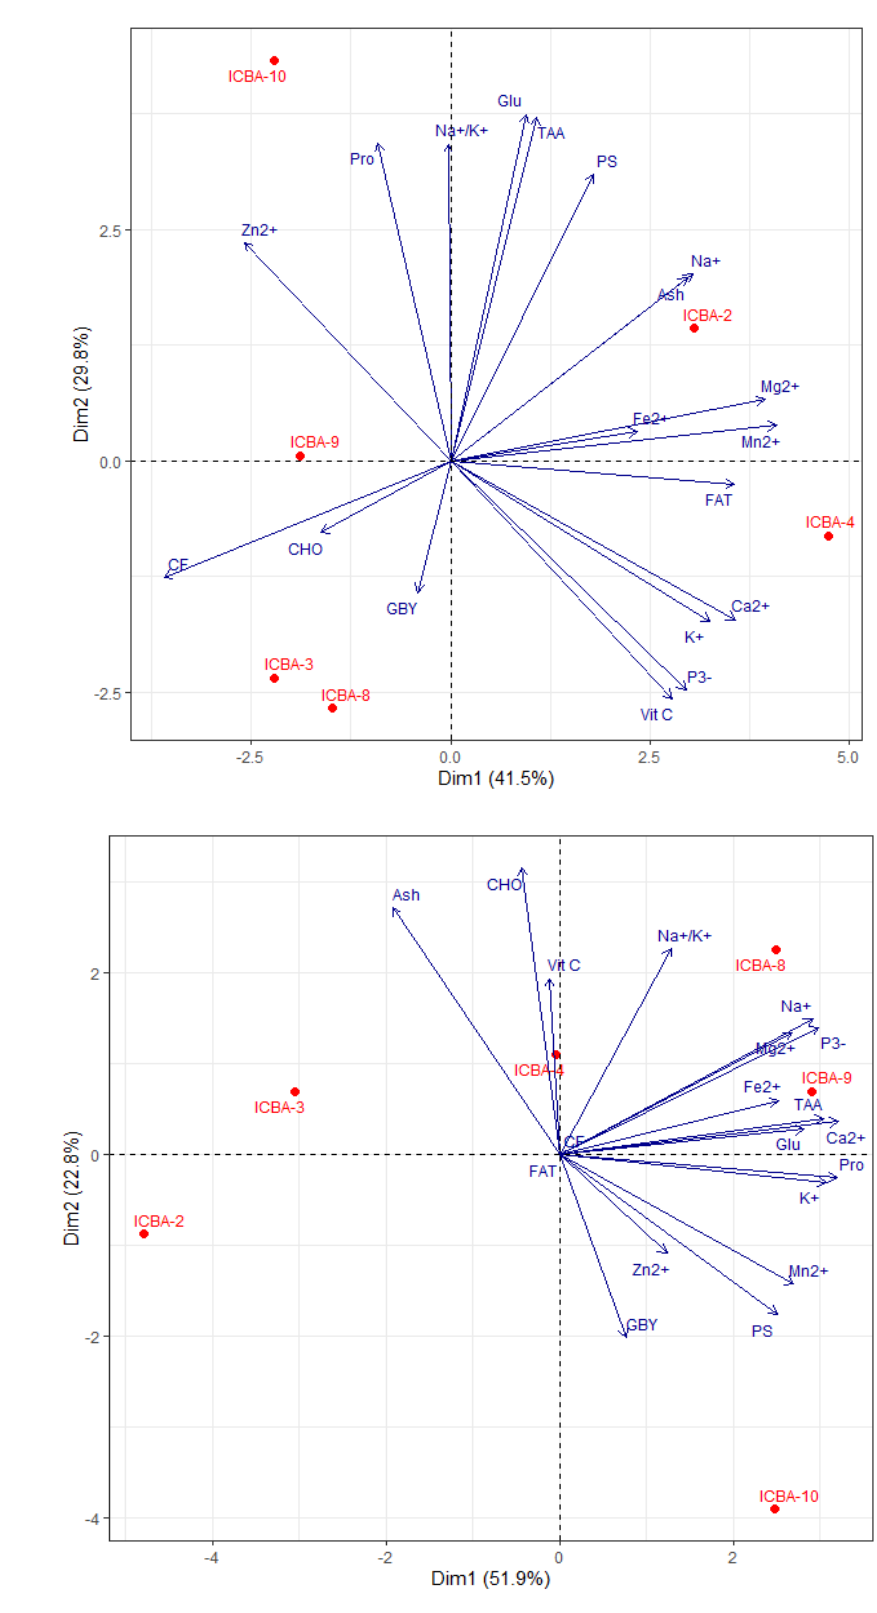
Figure 4. Plot of Principal Component Analysis (PCA) for the green biomass yield, proximate compo- sition, micronutrients and amino acids for six S. bigelovii genotypes at: ( a ) ICBA and ( b ) Mubarak Valley for the first two dimensions. See Table A7 for eigenvector values of each parameter for PCA dimension 1 (Dim1) and 2